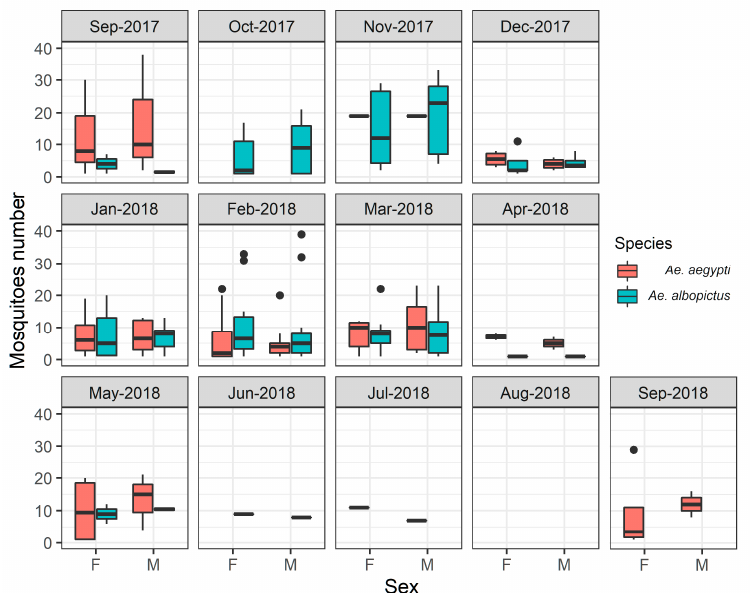
Figure 2. Frequencies of Aedes aegypti and Aedes albopictus adults by sex identified from hatching eggs, September 2017 to September 2018, Morretes, Paraná, Brazil. Trop. Med. Infect. Dis. 2022 , 7 , x FOR PEER REVIEW Considering the 23 collection sites selected, a higher collection of eggs was observed at collection points 15 and 23 (N = 8), being eight months with positive collections), fol- lowed by collection points: 9 (N = 7), 17 and 22 (N = 6), 4, 11 and 16 (N = 5), 2, 3, 10, 13, 18 and 19 (N = 4), 1, 5, 8 and 21 (N = 3), and 7 and 20 (N = 2) (Figure 3; Table 1). Aedes aegypti identified from eggs were present at different collection points in the central area of Mor- retes, and the highest numbers were found at collection points 4 (N = 66, 9.57%), 9 (N = 64, 9.28%), 11 (N = 64, 9.28%), 15 (N = 148, 21.48%), 18 (N = 64, 9.28%) and 23 (N = 59, 11.57%) (Figure 3A). Aedes albopictus identified from eggs were present in high numbers at collec- tion points: 11 (N = 117, 11.57%), 13 (N = 118, 11.67%), 15 (N = 100, 9.89%), 16 (N = 76, 7.51%), 17 (N = 96, 9.49%) and 23 (N = 127, 12%) (Figure 3B). Only two collection points (12 and 14) showed no evidence of the presence of Aedes spp individuals. Overall, the highest occurrence of Aedes spp was observed in the central area of the city throughout the study period (Figure 3C).